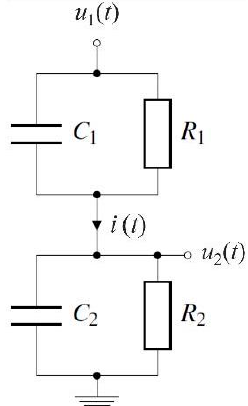
Figure 8. Schematic representation of the device under test connected to the reference impedance.